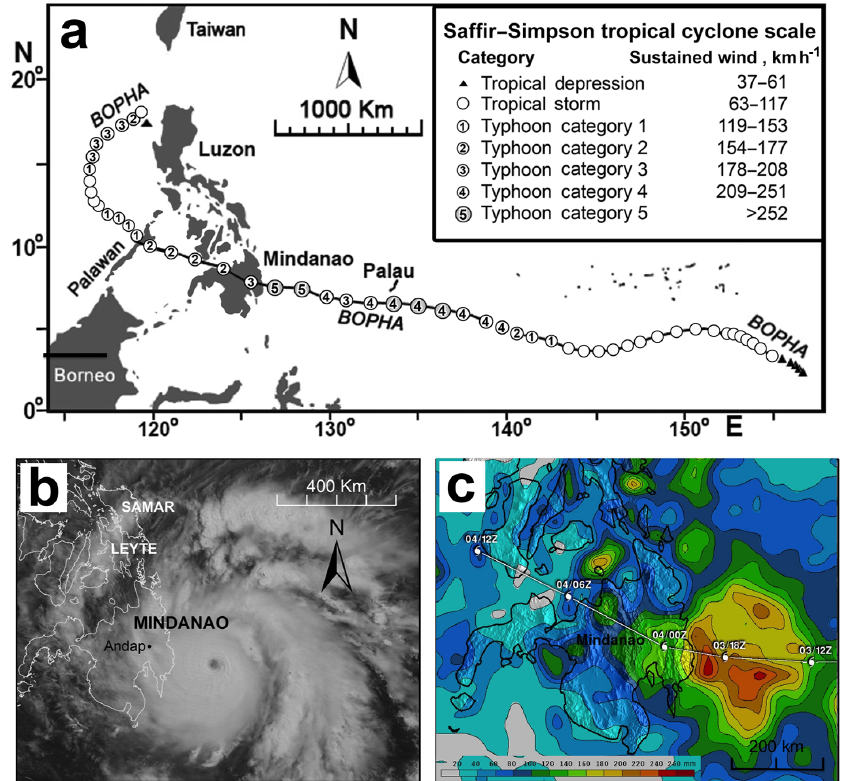
Figure 1. Typhoon Bopha (Pablo). (a) Track and development of the super typhoon. New Bataan, Andap and Maragusan rain gauges lie beneath the Category 3 icon following Mindanao landfall. (b) Bopha at landfall (modified from NASA Earth Observatory, 2012). (c) Tropical Rainfall Measurement Mission (TRMM) image from which NASA (2012) estimated that Bopha delivered over 240mm of rainfall near the